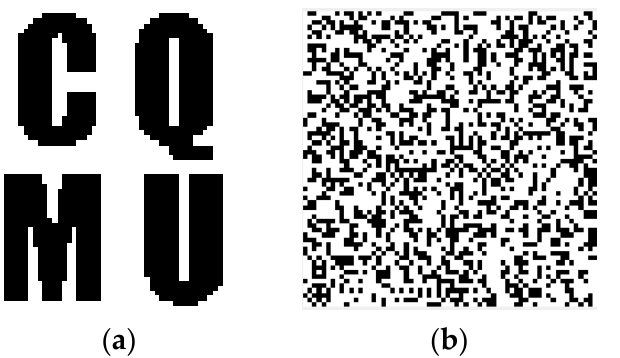
Figure 6. Original medical images: ( a ) brain; ( b ) chest; ( c ) hand; ( d ) fundus vessels; and ( e ) breast.